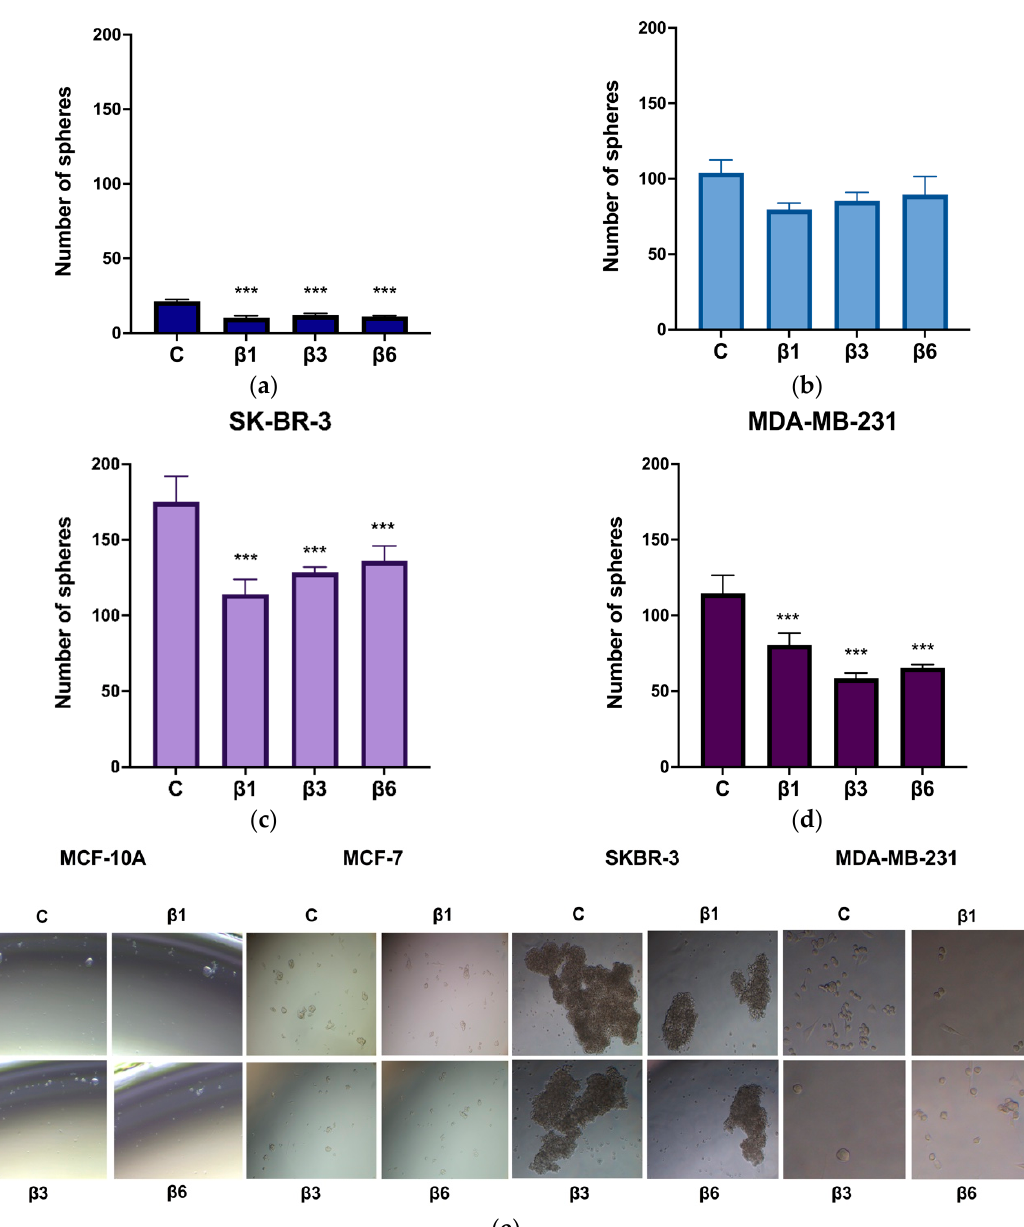
Figure 8. Quanti fi cation of mammospheres after treatment with β 1-conglutin (2.5 ng/µL), β 3-conglutin (5 ng/µL), and β 6-conglutin (10 ng/µL). Treatment was performed 24 h before seeding mammospheres from ( a ) MCF-10A, ( b ) MCF-7, ( c ) SK-BR-3, and ( d ) MDA-MB-231 and spheres were characterized in ( e ). After 24 h of ( a ) β 1, ( b ) β 3, and ( c ) β 6-conglutin treatment, cells were trypsinized and, from each condition, a 12 well triplicate with 1 × 10 2 cells/well were seeded in ultra-low a tt achment plates in spheres medium (described in 2.9). Spheres > 50 µm were counted and captured using Leica DM500 binocular microscope at 10x magni fi cation. *** p < 0.001 vs. non-treated cells.